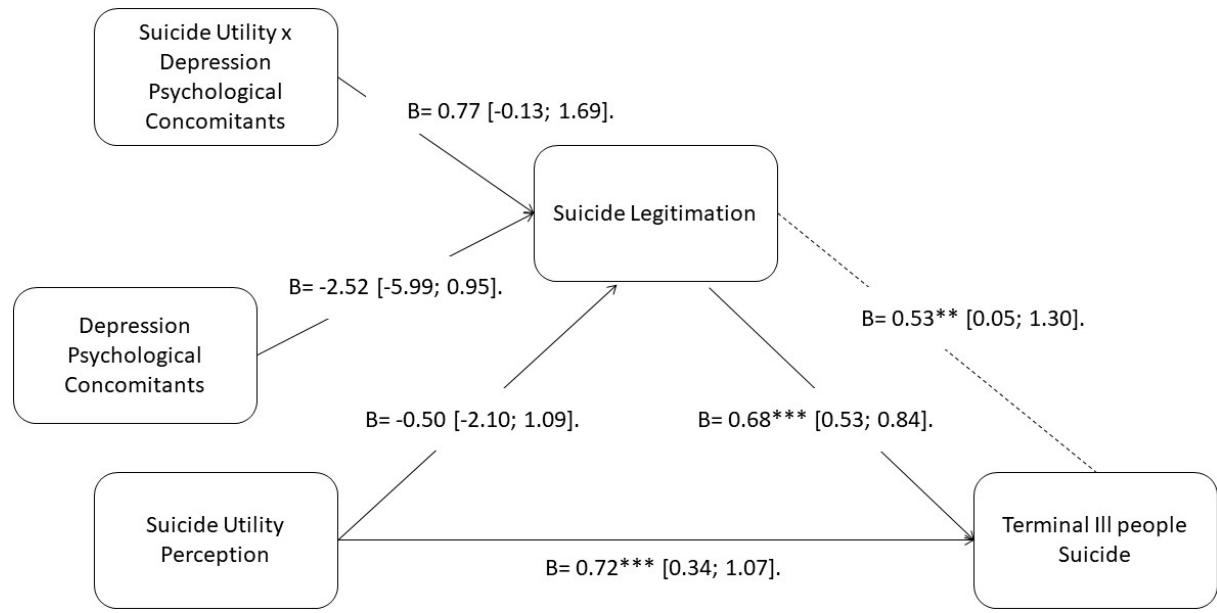
Figure 2. Statistical model where coefficients and effect sizes may be observed. Note: *** p < 0.001. ** p < 0.01.